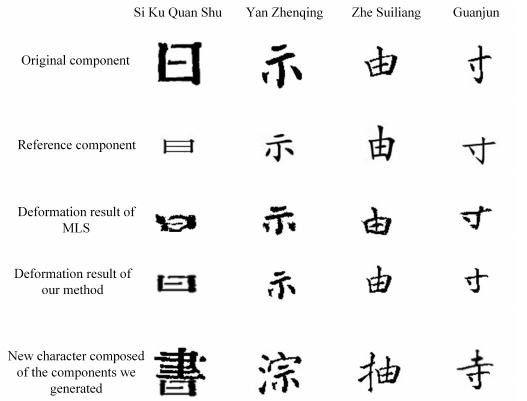
Figure 11. From left to right, the components are from Si Ku Quan Shu, Yan Zhenqing, Zhe Suiliang, and Guanjun. From top to bottom are the original components used for deformation, the reference components during deformation, the components generated by MLS, the components generated by our methods, and the characters containing the new components we